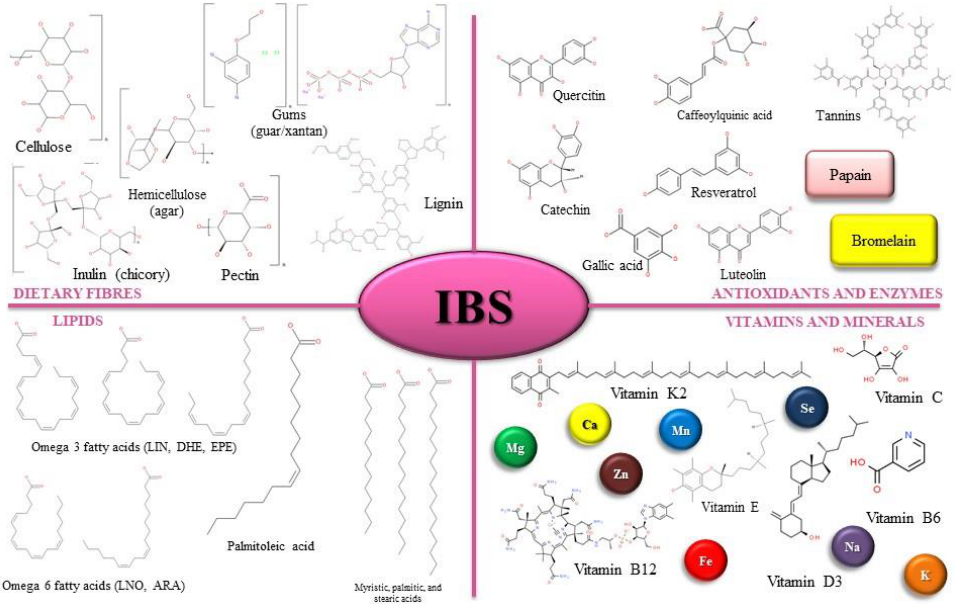
Figure 2. Biomolecules that are potentially relevant to IBS symptomatology management (molecular structures added using BIOVIA Draw 19 software, 2019 by San Diego: Dassault Systèmes and IUPAC names available on PubChem database).